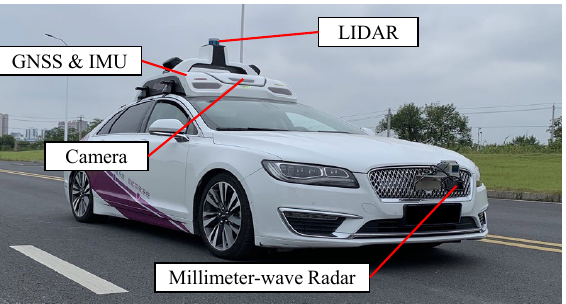
Figure 12. The modified Lincoln MKZ with an autopilot system used in the field